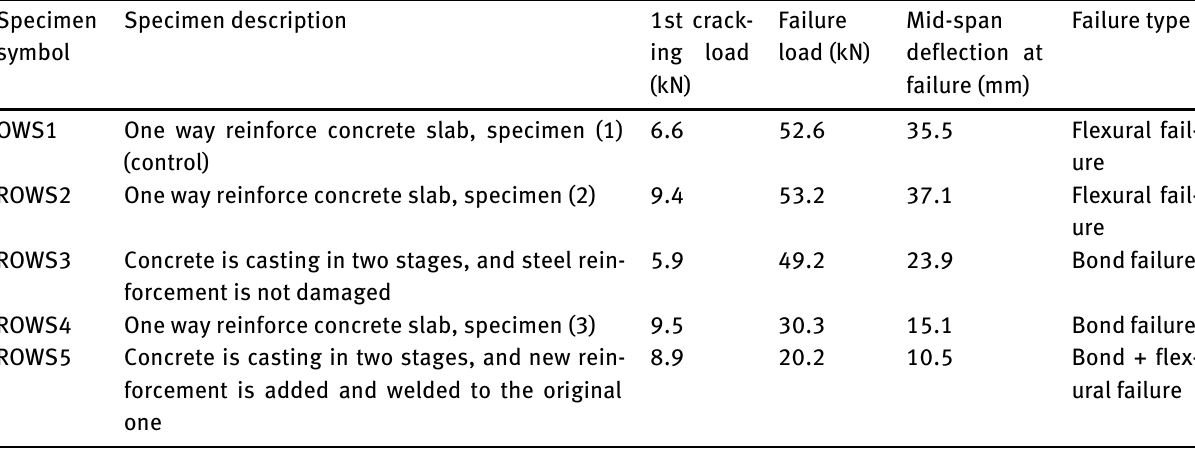
Table 1: First cracking load, failure load, and mid-span deflection at failure load of specimens.